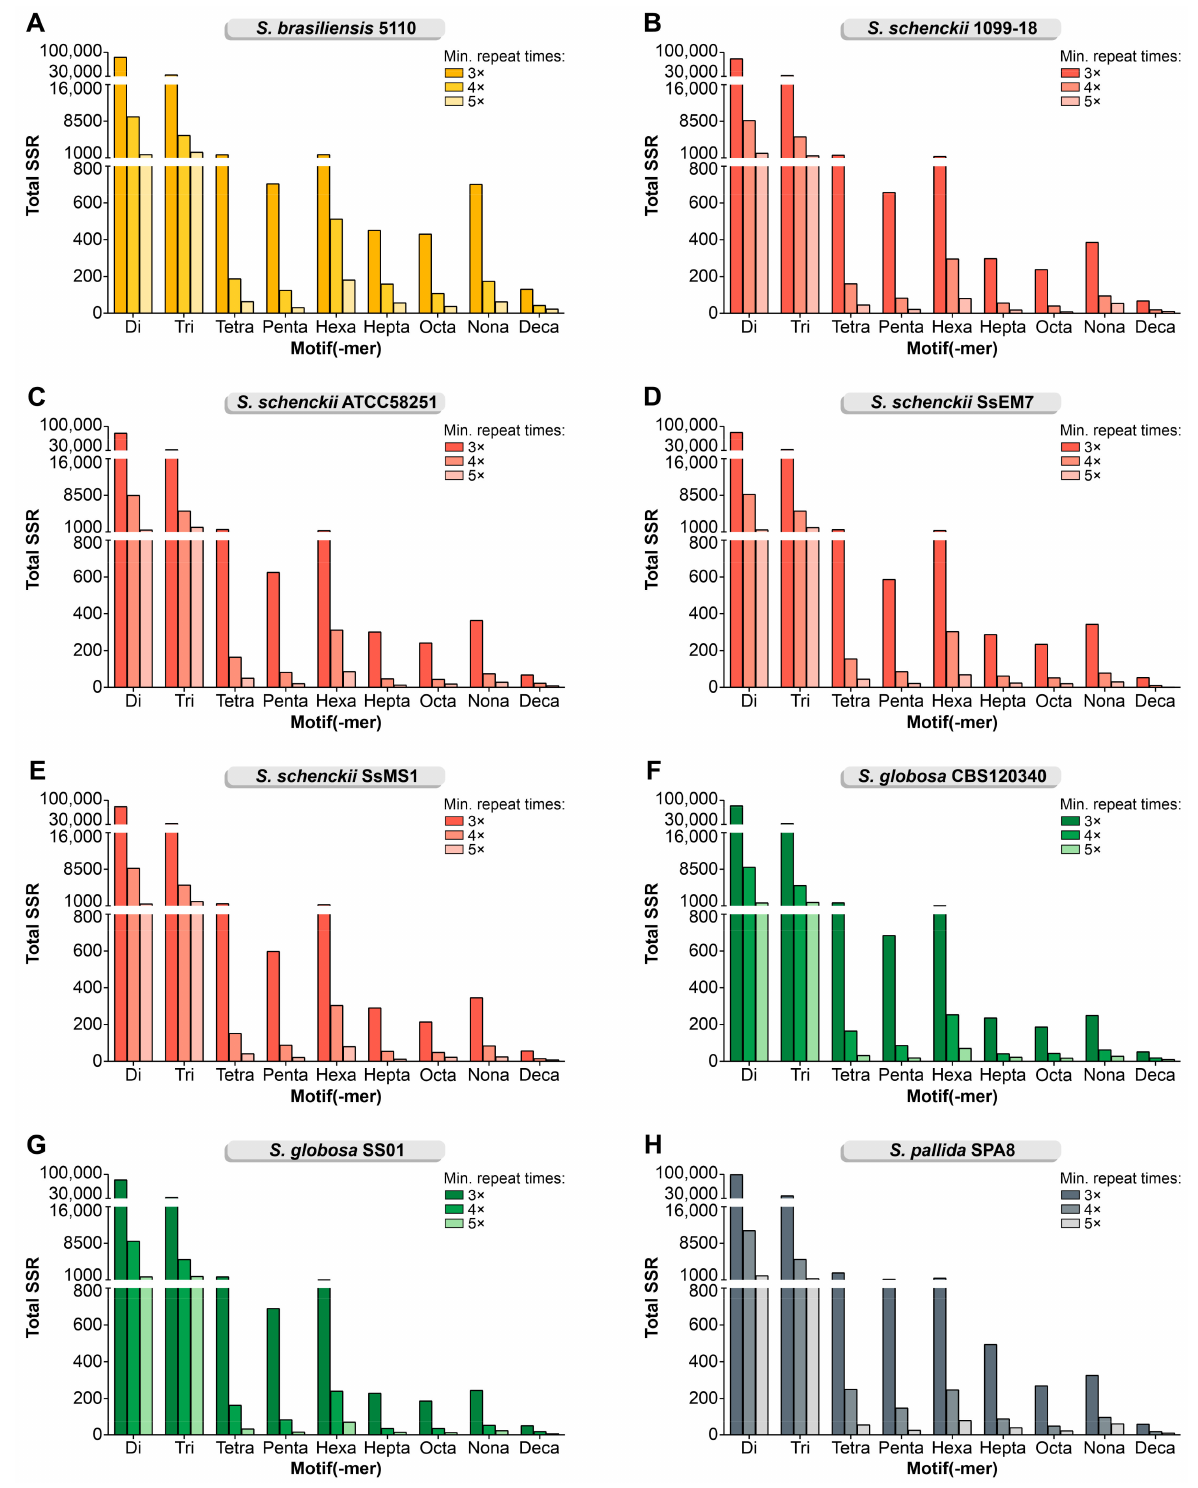
Figure 1. SSR markers with a minimum of 3, 4, or 5 repeats and motifs of 2–10 bp in the Sporothrix genomes were analyzed in GMATA using the default settings: ( A ) S. brasiliensis 5110; ( B ) S. schenckii 1099-18; ( C ) S. schenckii ATCC 58251; ( D ) S. schenckii SsEM7; ( E ) S. schenckii SsMS1; ( F ) S. globosa CBS 120340; ( G ) S. globosa SS01; ( H ) S. pallida